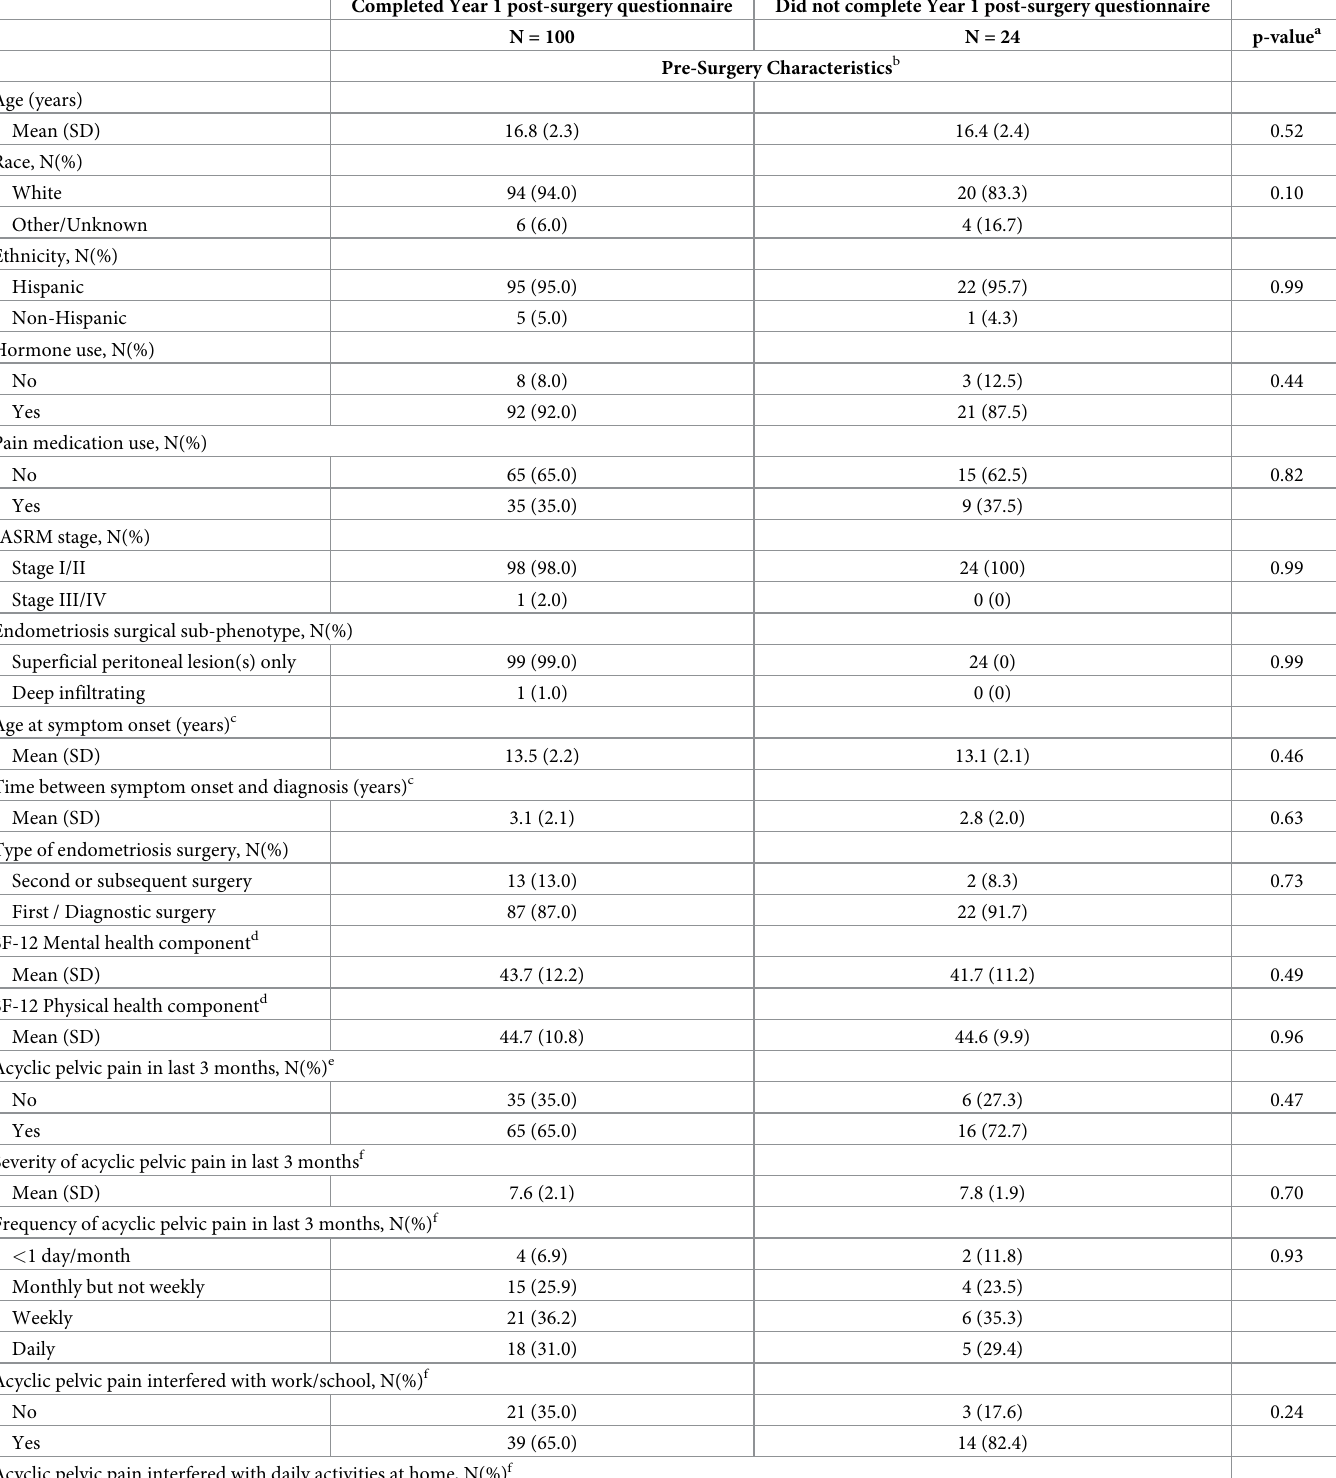
Table 3. Comparison of pre- and post-surgery characteristics for participants who completed and did not complete the Y1 post-surgery